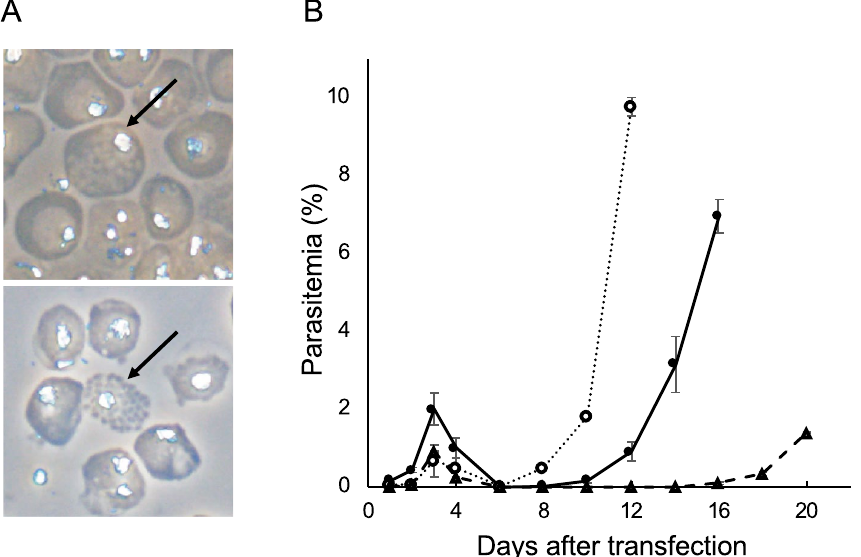
Figure 1. Transfection of fully mature schizonts of P. falciparum . ( A ) The fully mature schizonts enclosed within a single membrane of the parasitophorous vacuole (upper) or erythrocyte (lower) are indicated by arrows. ( B ). Purified schizonts, including fully mature schizonts, were transfected with 5 μg (closed circle/ solid line) and 50 μg (opened circle/dashed line) of pFCENv1 plasmid. Five micrograms of pFCENv1 was also preloaded into RBCs and then introduced into the parasite by uptake (closed triangle/dashed